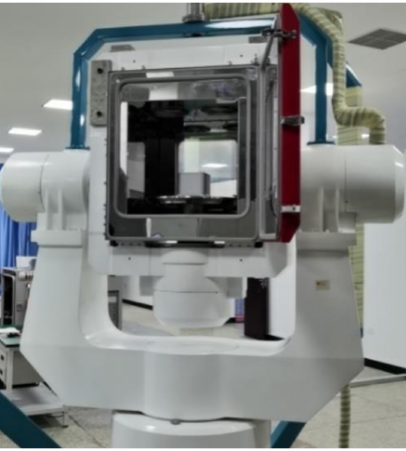
Figure 8. FOG IMU on three-axis turntable.